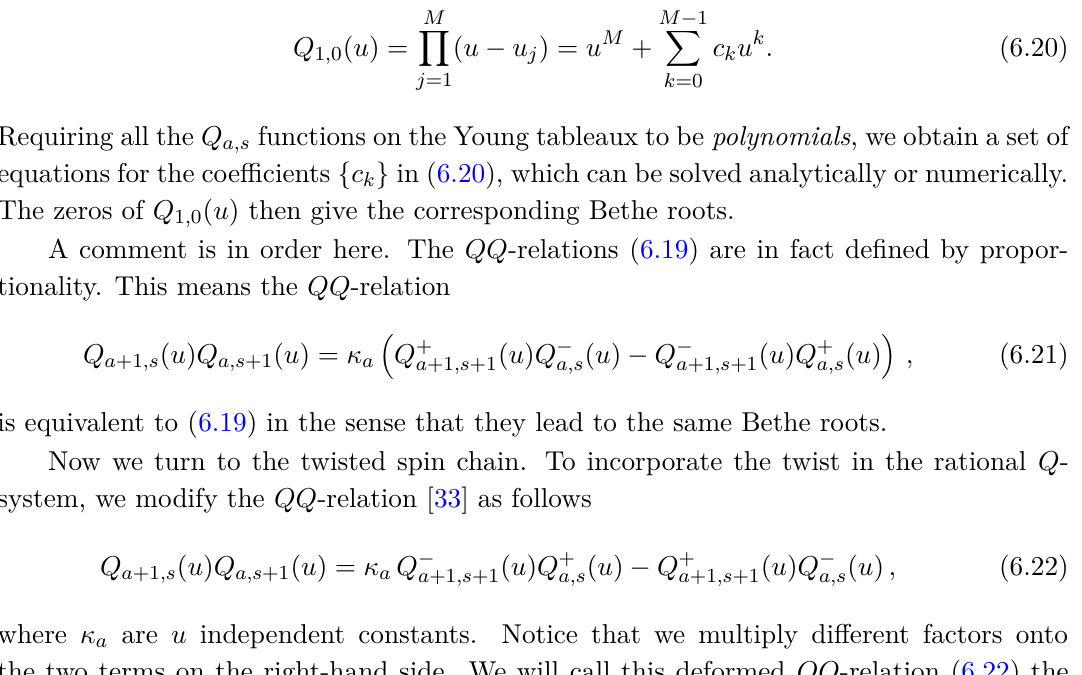
. The number in each circle denotes the power of a,s